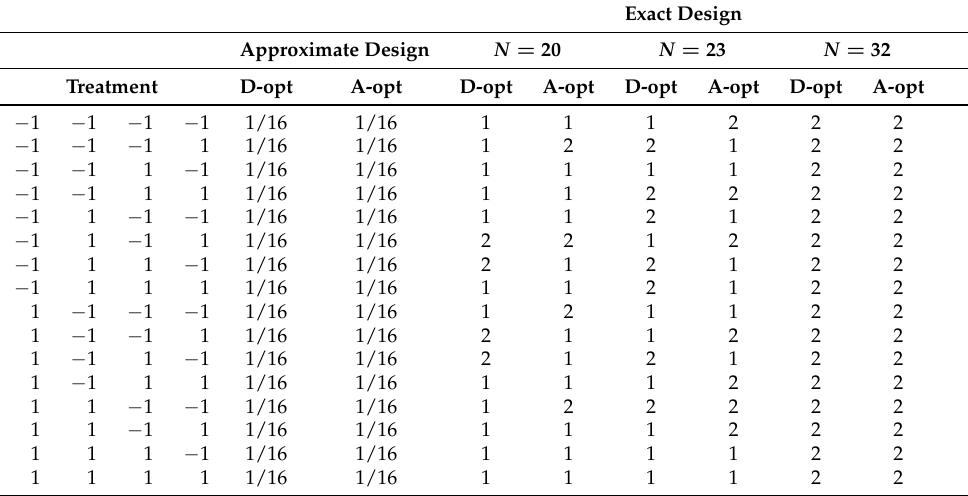
Table 3. D- and A-optimal designs for Model 2, where k = 16 and N = { 20,23,32 }